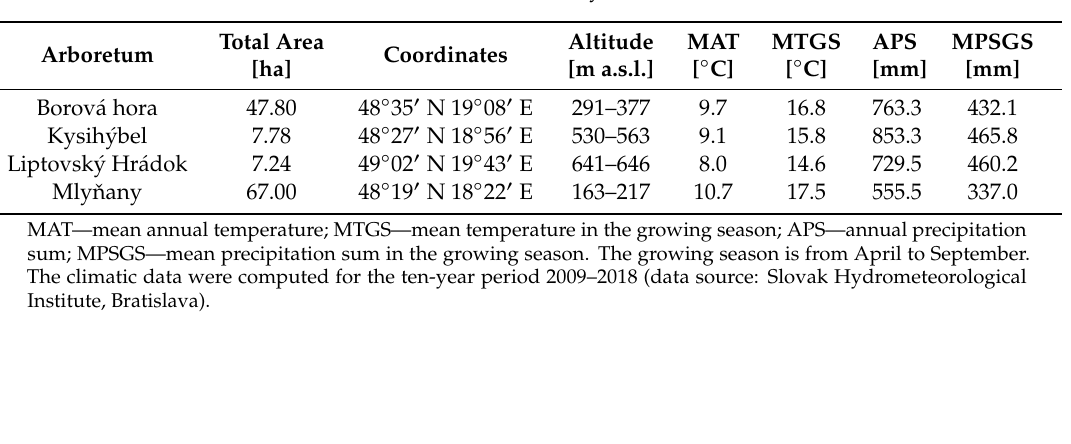
Figure 1. Map of Slovakia showing the four sampled arboreta. Table 1. Characteristics of study sites in